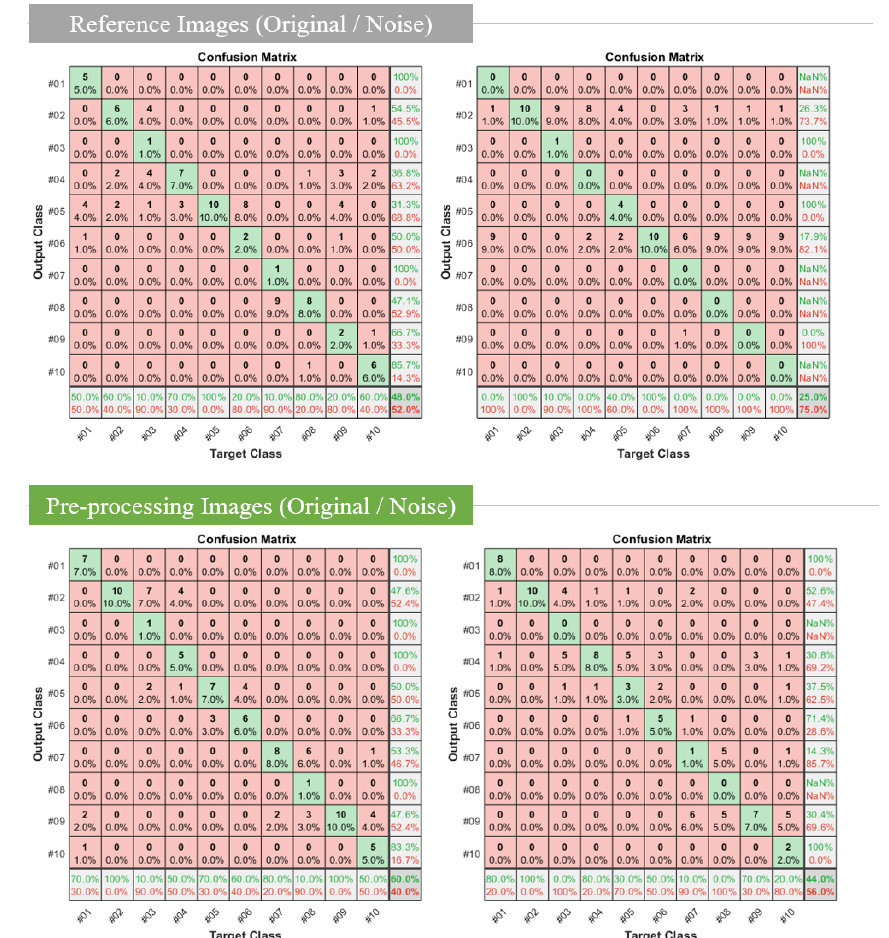
Figure 9. Comparison of confusion matrix